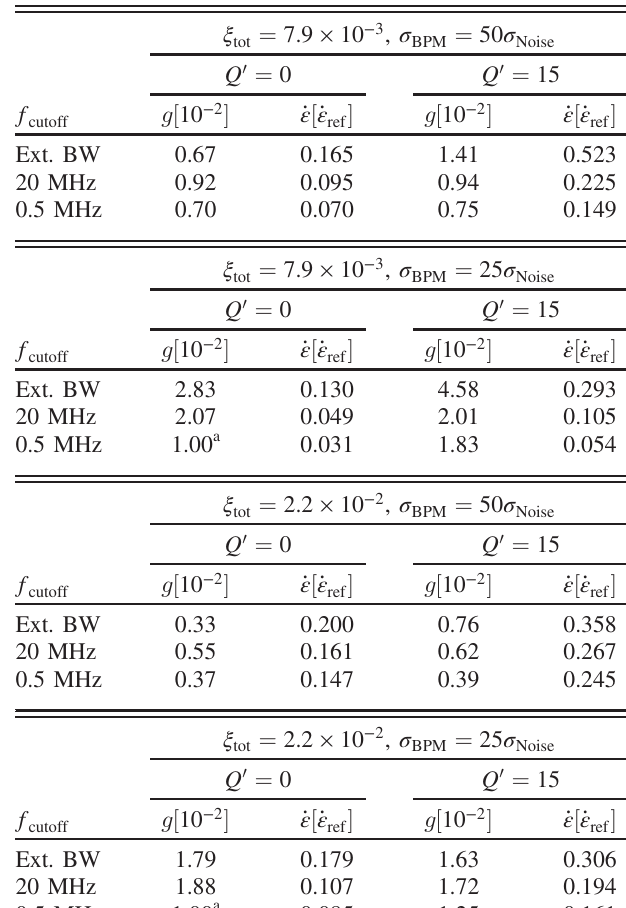
TABLE II. Minimal emittance growth rate and corresponding optimal gain for a given cutoff frequency, beam-beam parameter, noise ratio, and